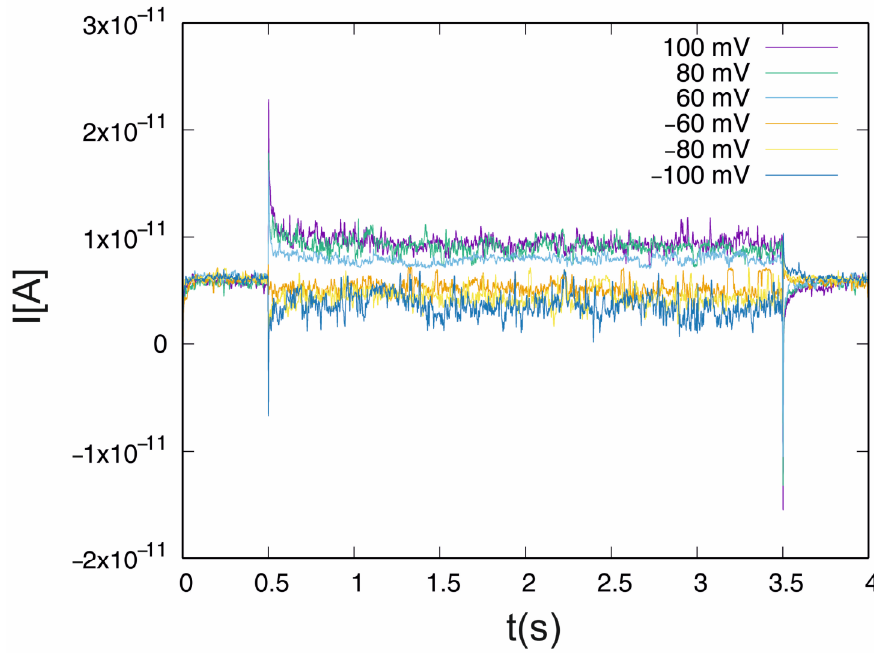
Figure 1. Examples of the signal recordings for the set of external potentials according to the experimental protocol.